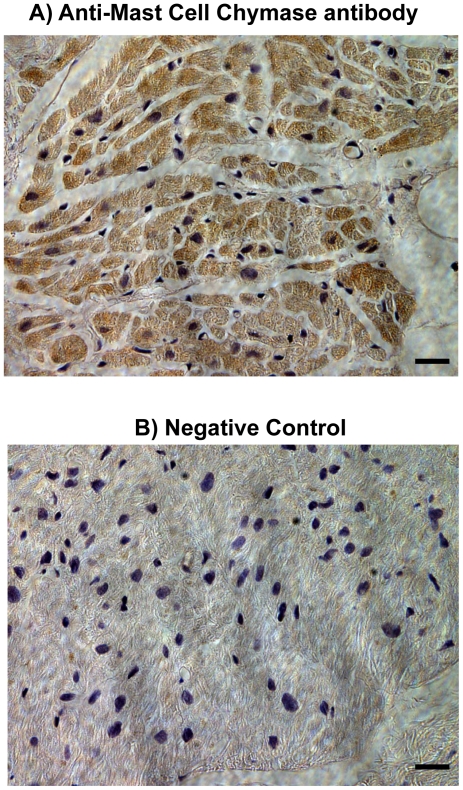
Immunohistochemistry of human atrial tissue for chymase.Immunostaining of human atrial tissue using an Anti-Mast Cell chymase antibody (Abcam Inc., Cambridge, MA; Cat# ab2377) revealed high expression of chymase within atrial cardiac myocytes (A). Negative control without primary antibody shows no staining for chymase (B). (Magnification 400; scale bar is 50 µm).